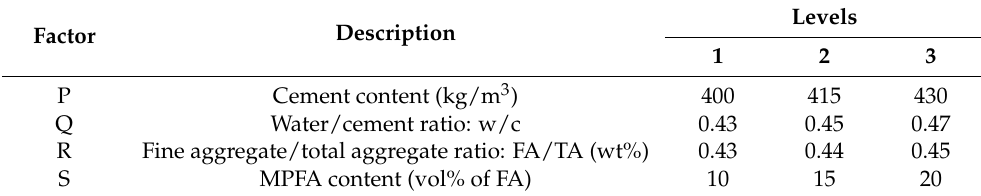
Table 3. Design factors and levels.